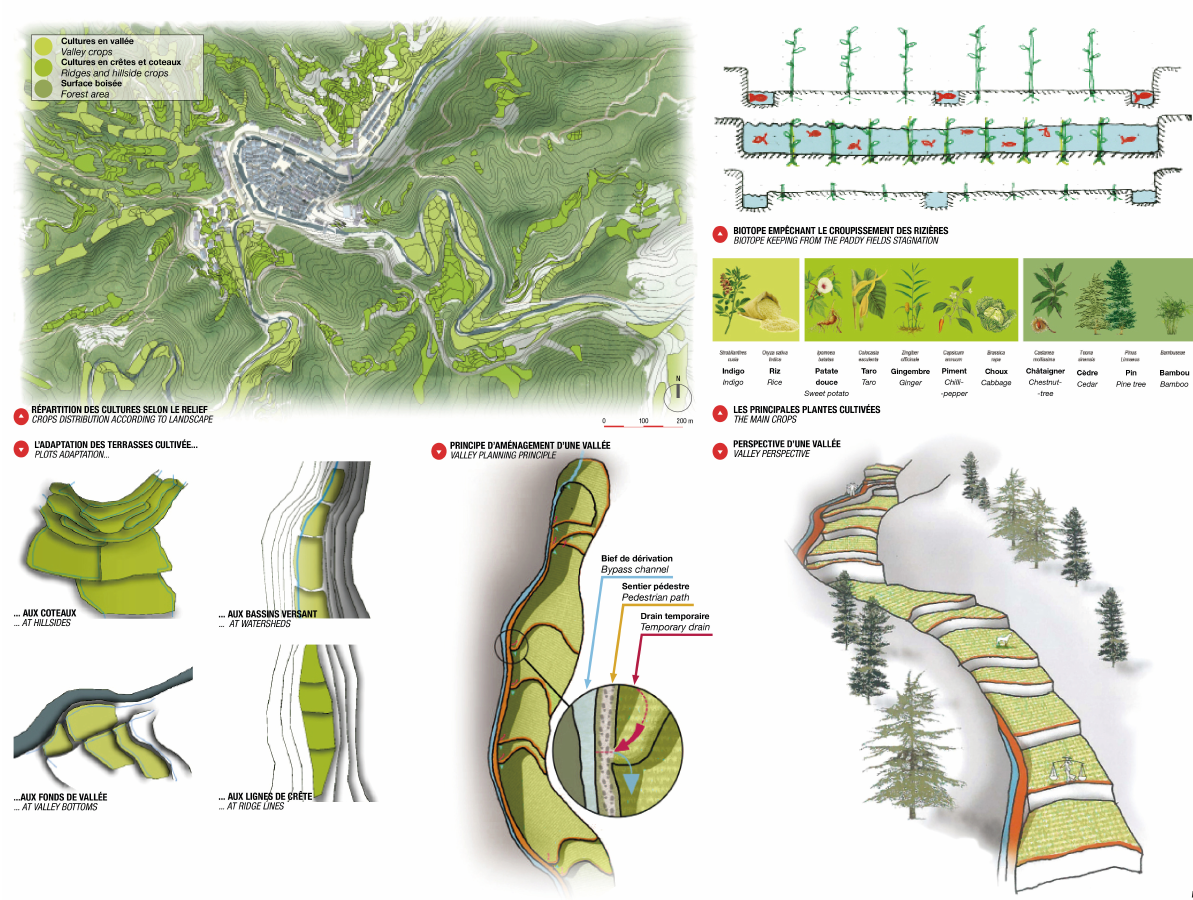
Figure 5 The terrace system (Source: outcome of Zengchong Chinese-French